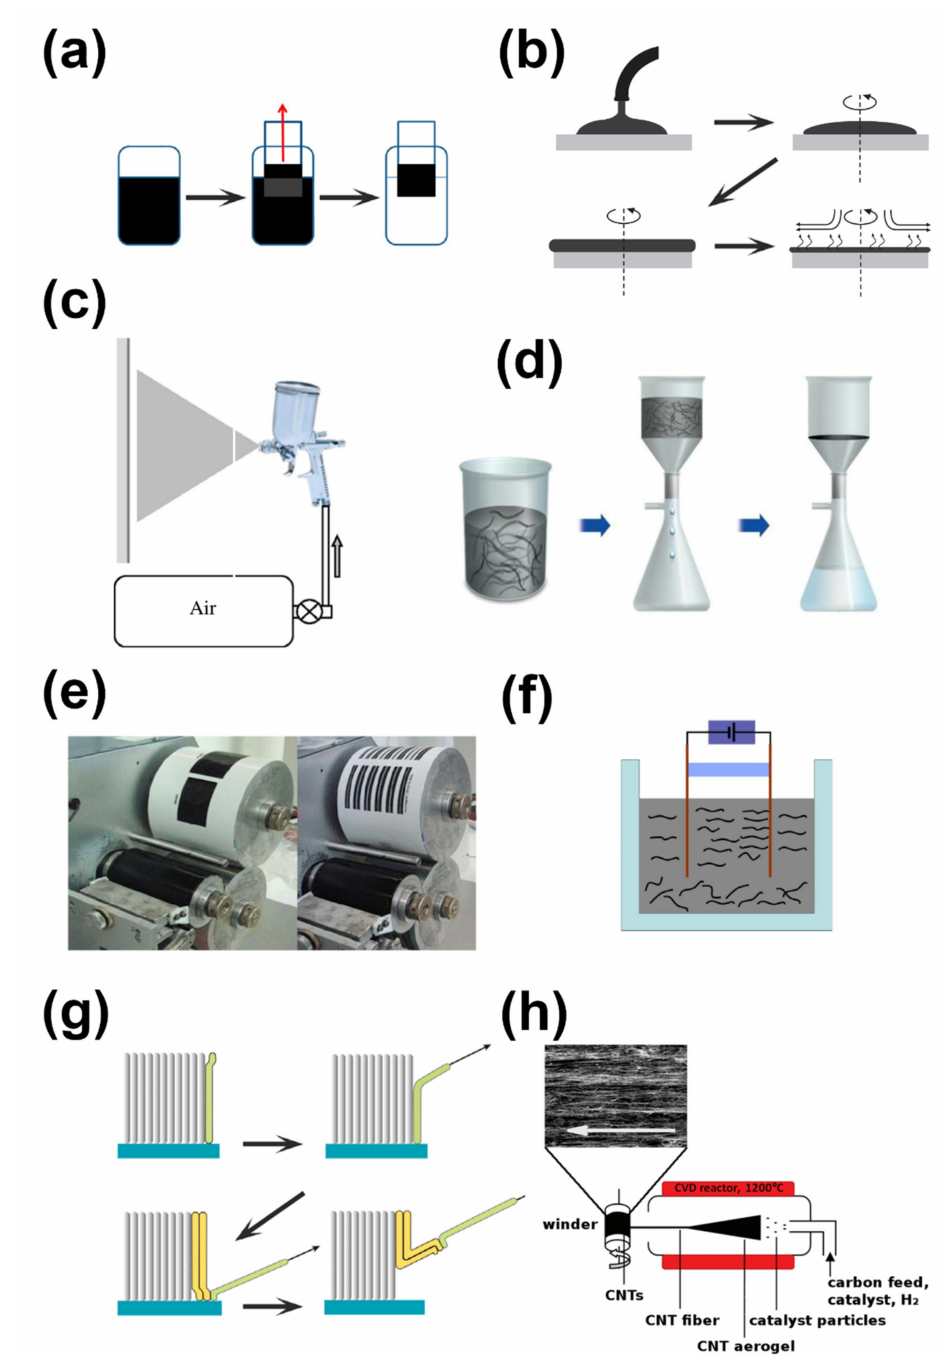
Figure 1. Overview of techniques of producing carbon nanotube (CNT) films. ( a ) Dip coating repro- duced with permission from [32], copyright the American Chemical Society (2012); ( b ) spin coating reproduced with permission from [43], copyright Woodhead Publishing Ltd. (2013); ( c ) spray coating reproduced with permission from [44], copyright Elsevier Ltd. (2012); ( d ) filtration reproduced with permission from [45], copyright MDPI (2016); ( e ) printing reproduced with permission from [46], copyright SAGE Publications Ltd. (2011); ( f ) electrophoresis reproduced with permission from [47], copyright Elsevier Ltd. (2006); ( g ) array drawing reproduced with permission from [48], copyright IOP Publishing Ltd. (2009); and ( h ) direct spinning reproduced with permission from [49], copyright Royal Society of Chemistry